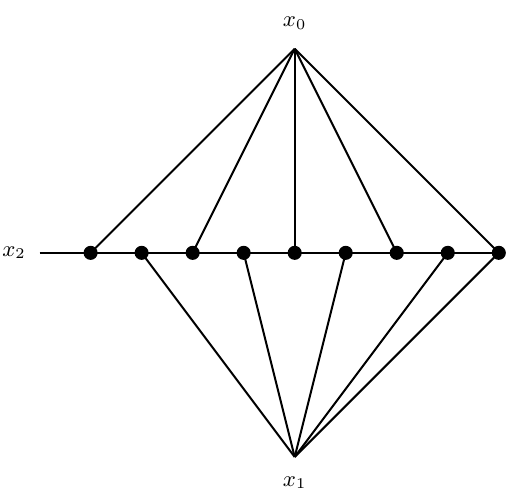
Figure 1 . Example of a zigzag integral, with integration vertices marked with